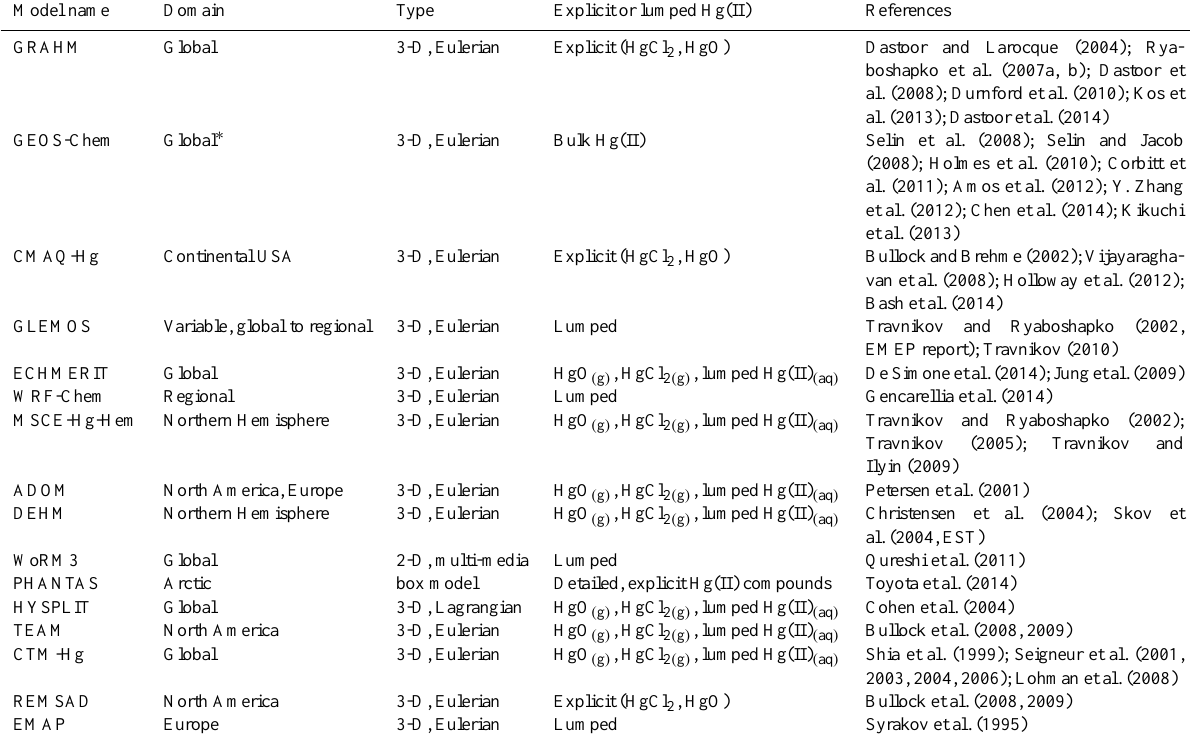
Table 3. Atmospheric models with speciated